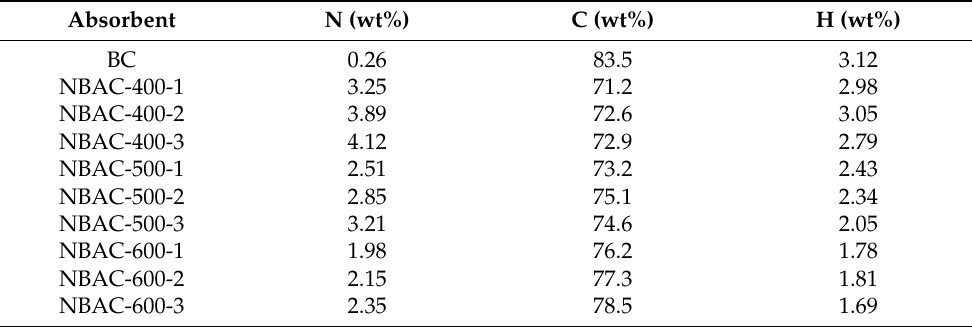
Table 2. Elemental content of NBACs synthesized by N-doping activation.